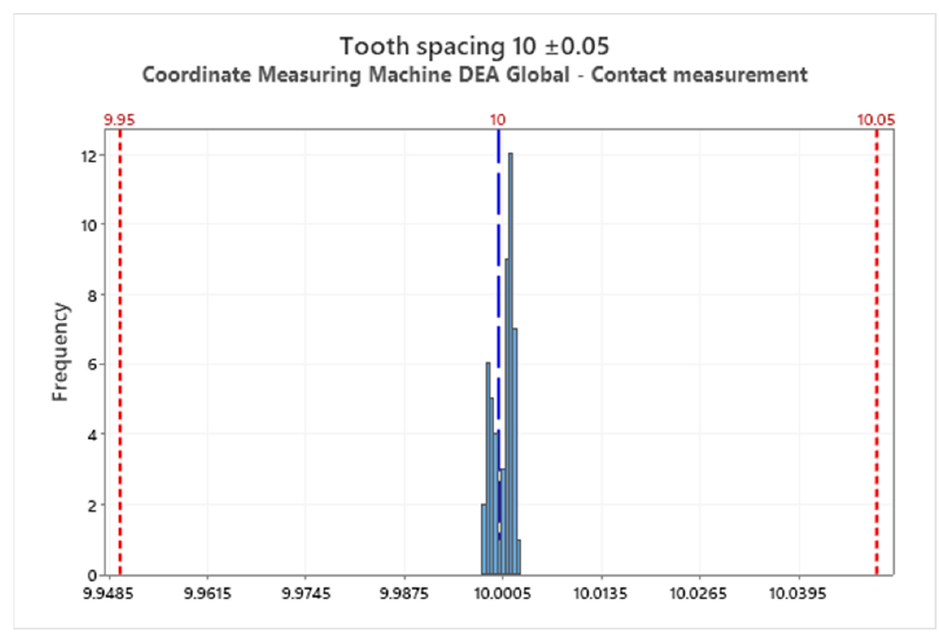
Figure 9. Tooth spacing 10 ± 0.05 mm—histogram from measurements obtained with the DEA Global Coordinate Measuring Machine, values on x axis given in mm (own study).